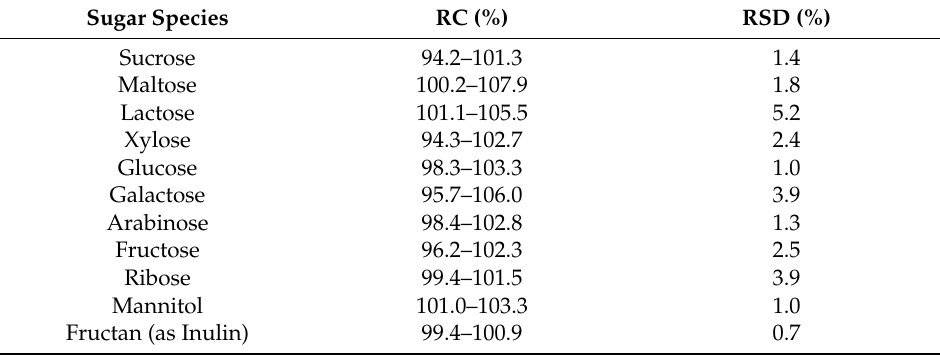
Table 9. Single sugars with recovery rate (RC, %) and relative standard deviation (RSD, %).